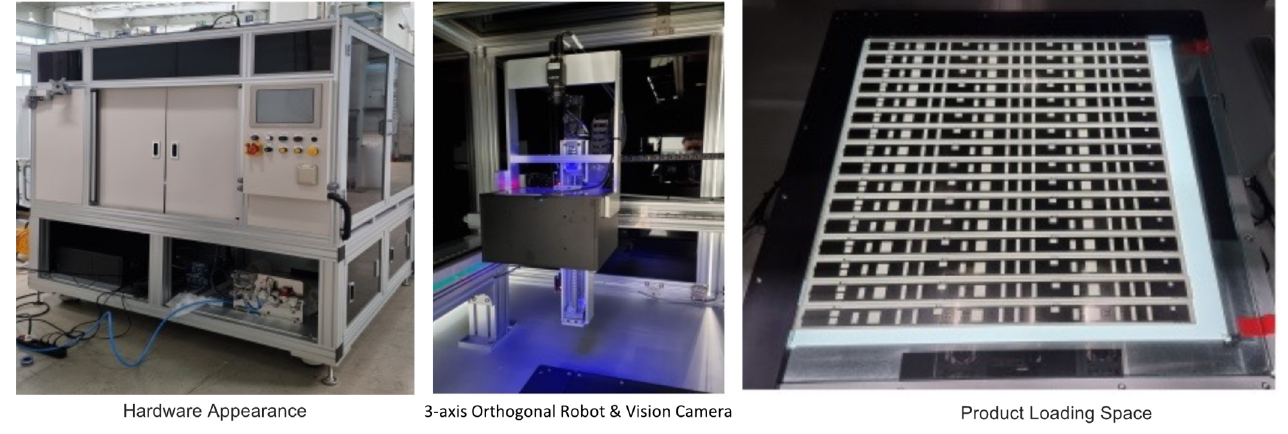
Figure 14. Appearance of the system consisting of the hardware.